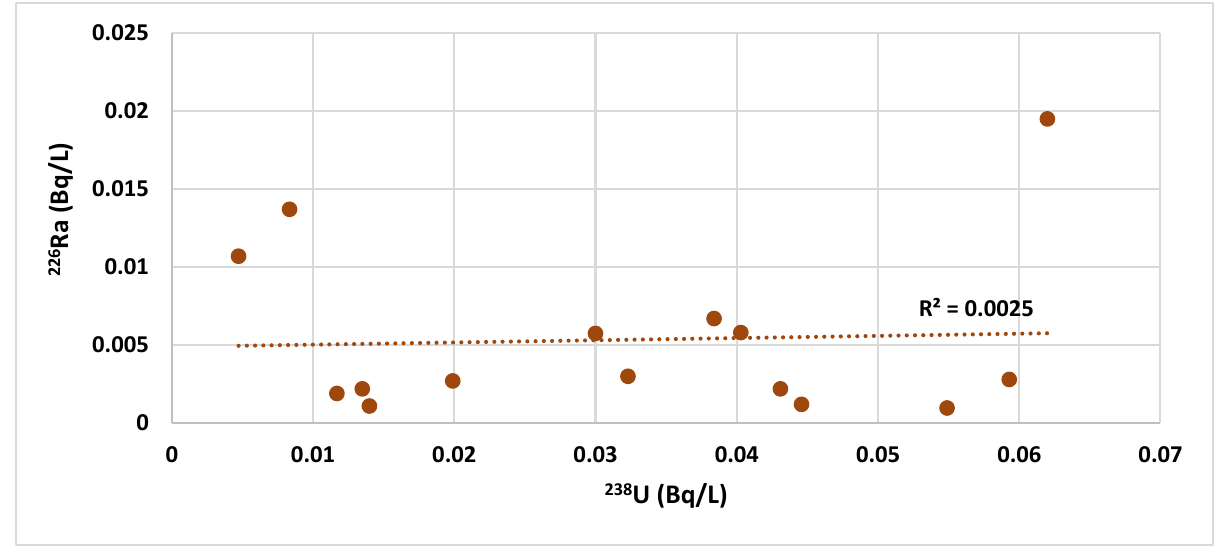
Table 2. 226 Ra activity concentrations in drinking water from around the world.